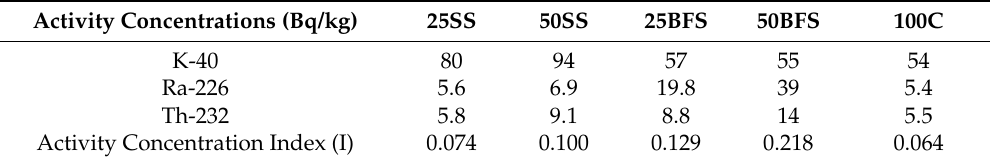
Table 9. Activity concentrations (Bq/kg) of radionuclides Ra-226, Th-232, K-40 and the activity concentration index, I, of SS, BFS, and